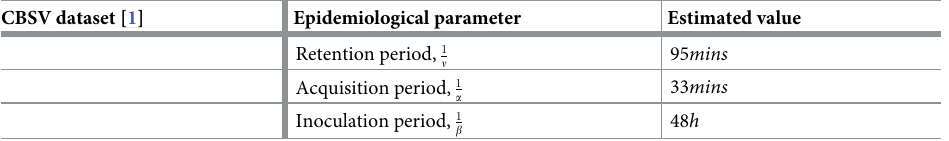
Table 3. Epidemiological parameter estimates for CBSV: An application of the method of matching gradients to a CBSV access period dataset.